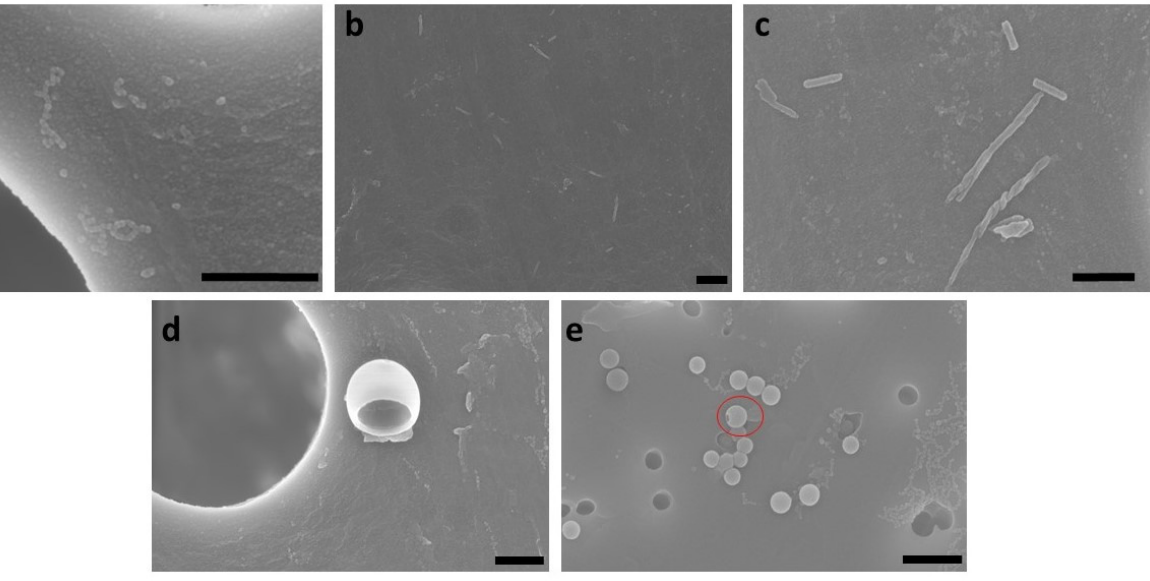
Figure 11. Exemplary SEM images to illustrate the postulated micelle-to-vesicle transition. ( a ) and ( b ) 0 rpm, 0 h, pearl necklaces from micelles and short smooth cylindrical micelles, ( c – e ) 400 rpm, 0 h, partially agglomerated, twisted cylindrical micelles (short and long), ( d ) 400 rpm, 0 h, basket structure, and ( e ) 100 rpm, 3 h, small vesicles (partly but not yet completely closed (see red circle)). The scale bar is 500 nm.